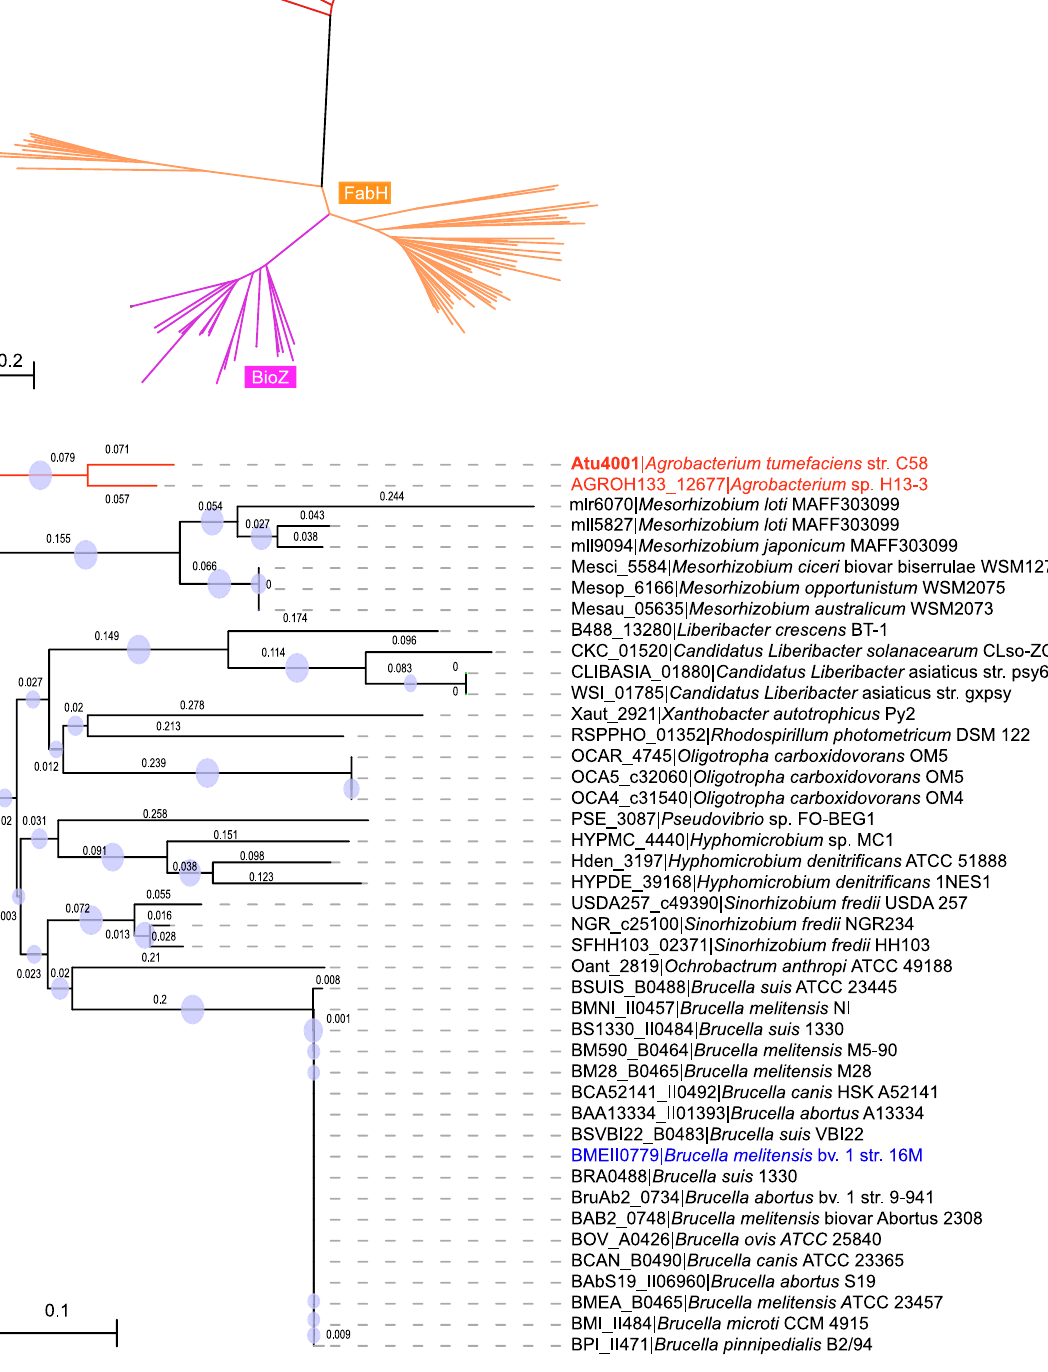
Fig. 2 Phylogeny of BioZ and its paralogs. a An unrooted tree of BioZ proteins and its putative homologs (FabH, FabB, and FabF). The phylogenetic tree was generated with the MEGA7 software using the NJ method (bootstrap: 1000 replicates). Two major clades of KAS enzymes are shown: FabF in red and FabH in orange. In contrast, FabB (shown in gray) is phylogenetically positioned as a sub-branch of FabF clade and BioZ was localized to a sub-branch of FabH clade. Therefore, we speculated that FabB originates from FabF (KAS II), and a recent ancestor of BioZ arises from FabH, the KAS III enzyme within the KAS pan-family. b Phylogenetic relationships of BioZ paralogs. Phylogeny was constructed using the MEGA7 software involving the NJ method (bootstrap: 1000 replicates, bootstrap values indicated by circle sizes). BioZ of Agrobacterium and Brucella melitensis are colored in red and blue, respectively.